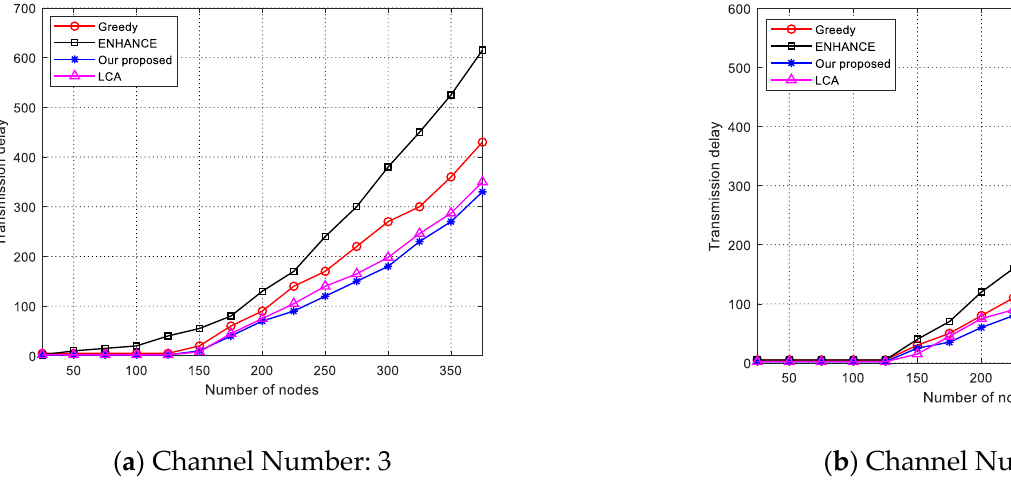
Figure 14. Transmission delay with different channel numbers.